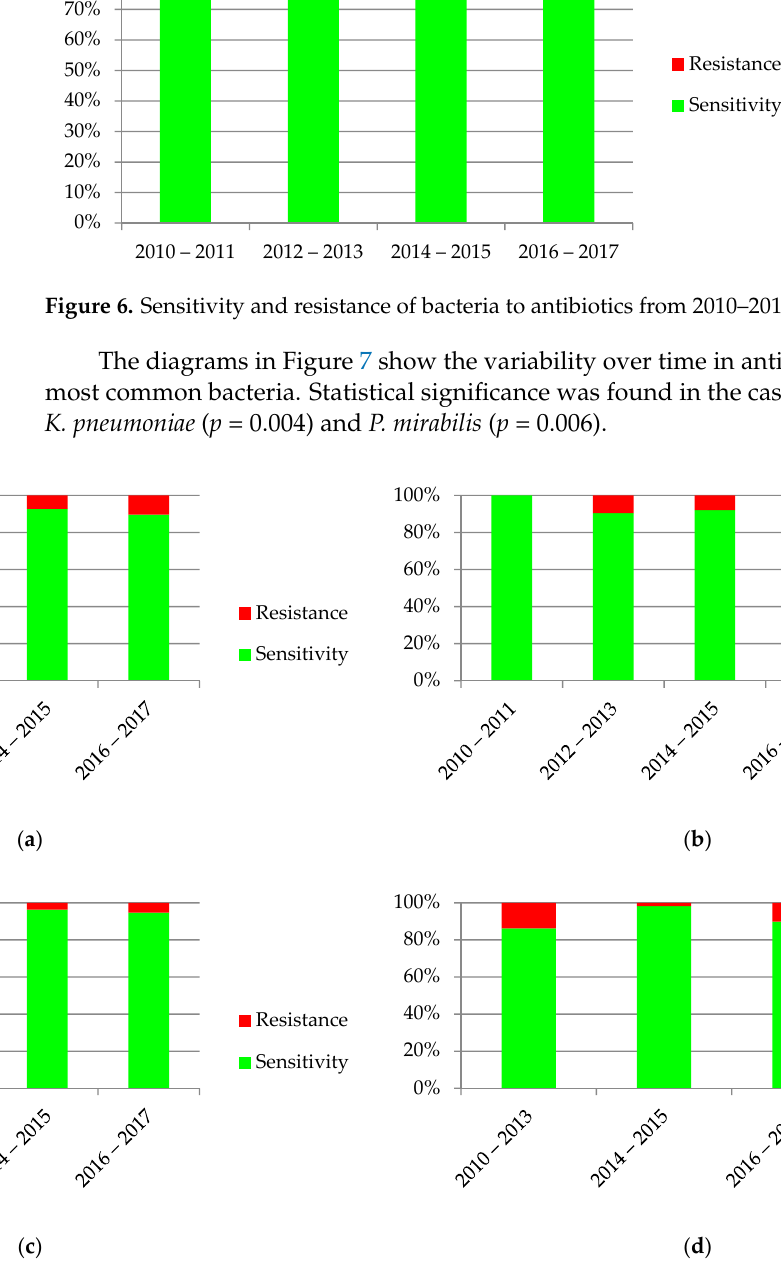
Figure 7. Sensitivity and resistance of bacteria to antibiotics from 2010–2017: ( a ) Escherichia coli ; ( b ) Pseudomonas aeruginosa ; ( c ) Klebsiella pneumonia ; ( d ) Proteus mirabilis .